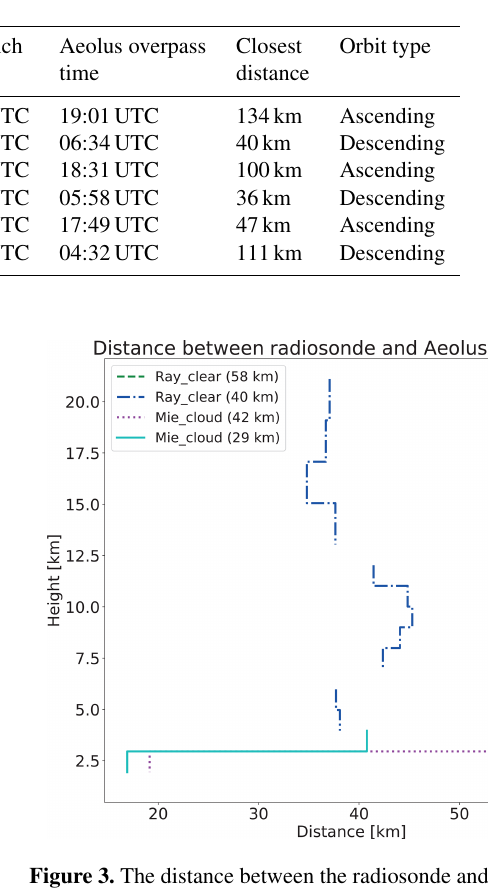
Table 1. Overview of Aeolus validation cases performed on board RV Polarstern with radiosonde (RS) launches during cruise PS116. The date, the location of RV Polarstern during the RS launch, the launch time, the time of the exact Aeolus overpass, and the distance between the radiosonde and the closest Aeolus wind profile are given. The last column indicates whether Aeolus had an ascending node during local evening or an descending node during local morning.